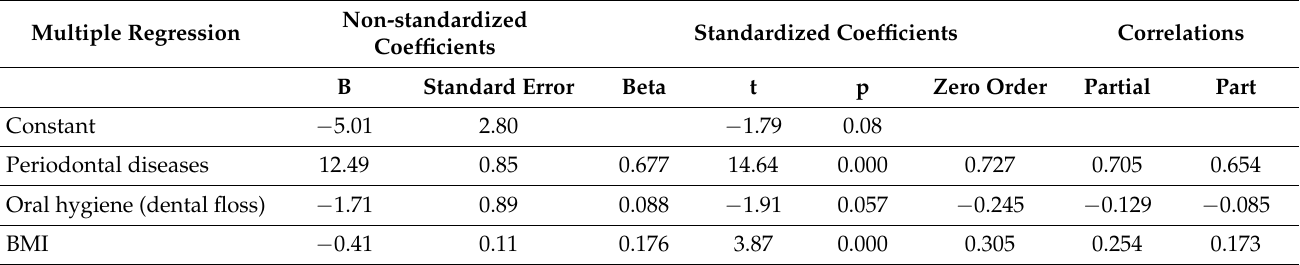
Table 4. Beta-standardized coefficients indicating a significant influence of the independent varia- bles on the dependent variable (quality of life).